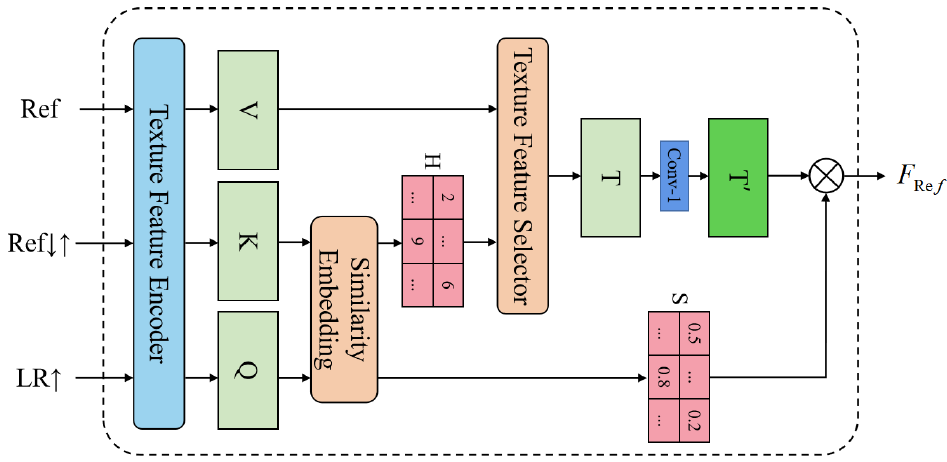
Figure 3. The improved texture transformer